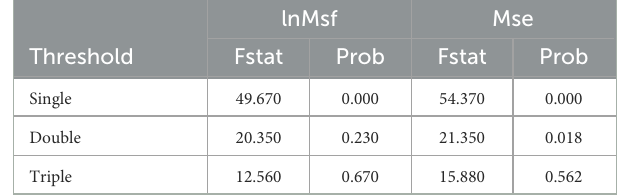
TABLE 4 Bootstrap test results.